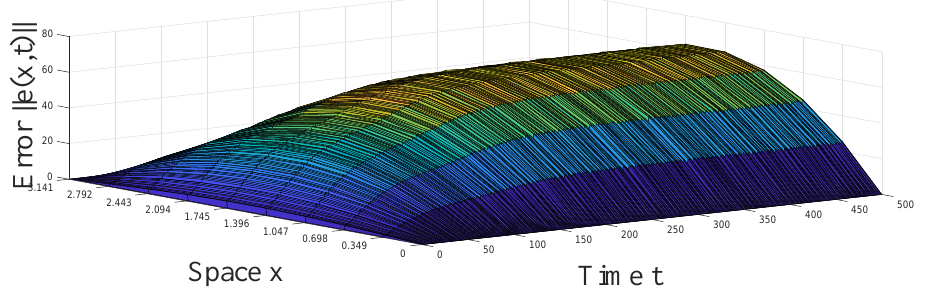
Figure 1. Spatiotemporal evolution of the error norm (cid:107) e ( x , t ) (cid:107) between systems (2) and (3) without